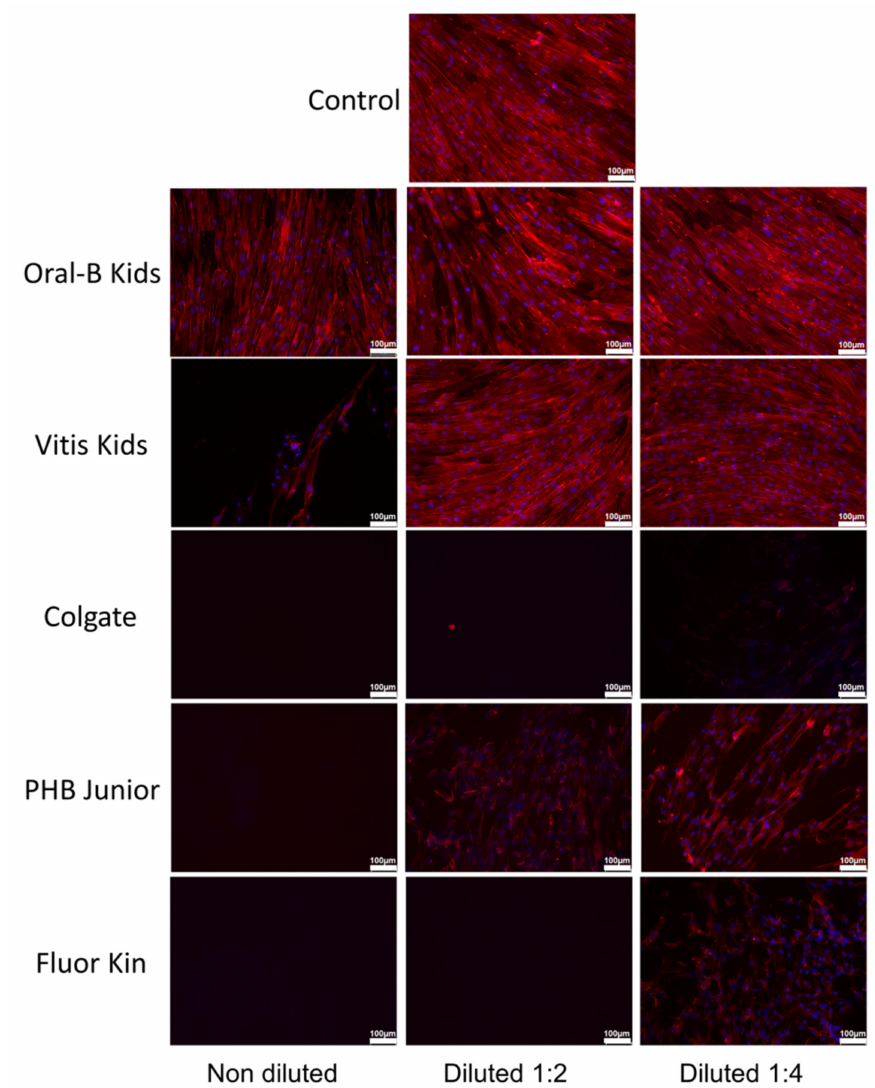
Figure 3. Morphological aspects and cytoskeleton F-actin fibers organization on hGF cultures exposed to different children’s toothpastes by confocal fluorescence microscopy. F-actin fibers were stained with AlexaFluor™ 594-labeled phalloidin (red fluorescence), whereas cell nuclei were counterstained with DAPI (blue fluorescence). Scale bar: 100 µ